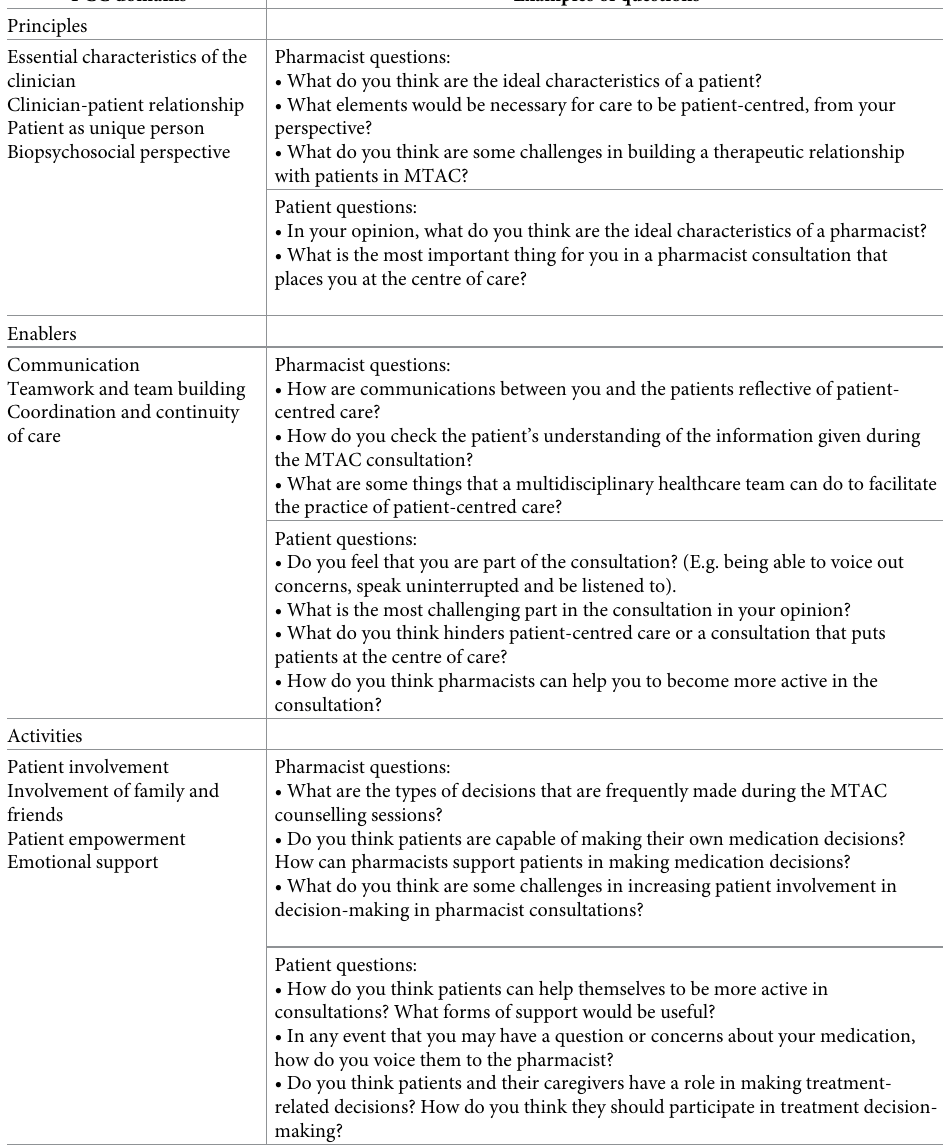
Table 1. Examples of interview